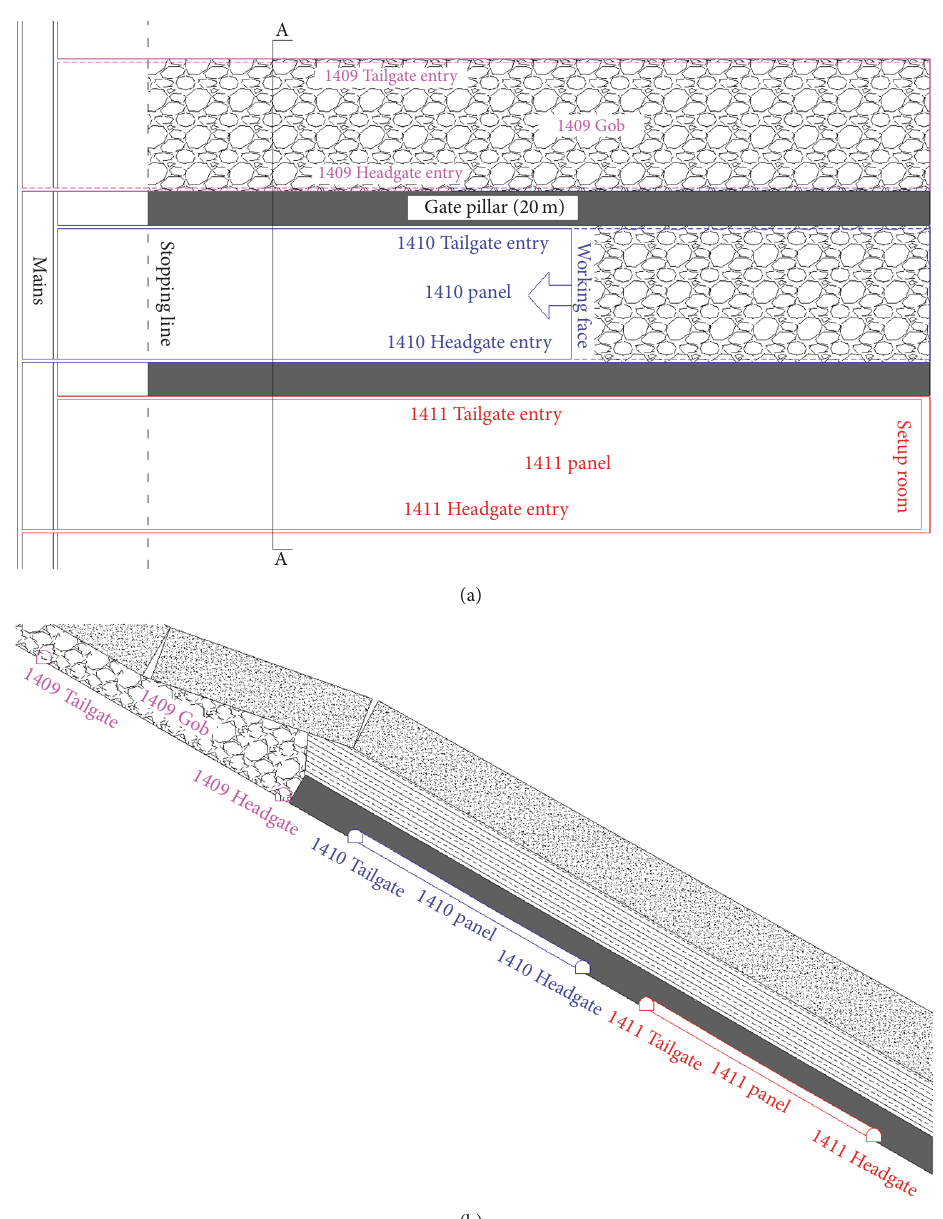
Figure 5: Original layout of 1409, 1410, and 1411 panels (not to scale). (a) Plan view, (b) A-A section